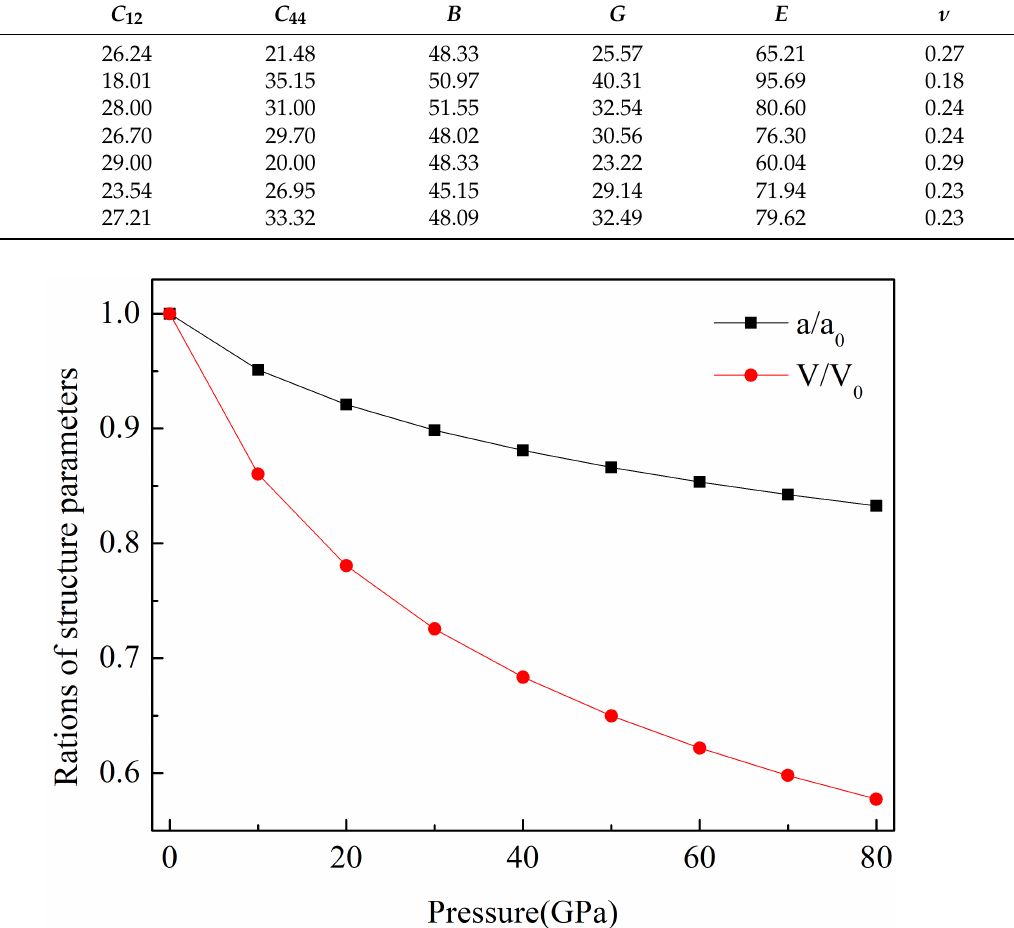
Table 1. The elastic constants, modulus, and Poisson’s ratio of the β -Mg 17 Al 12 .